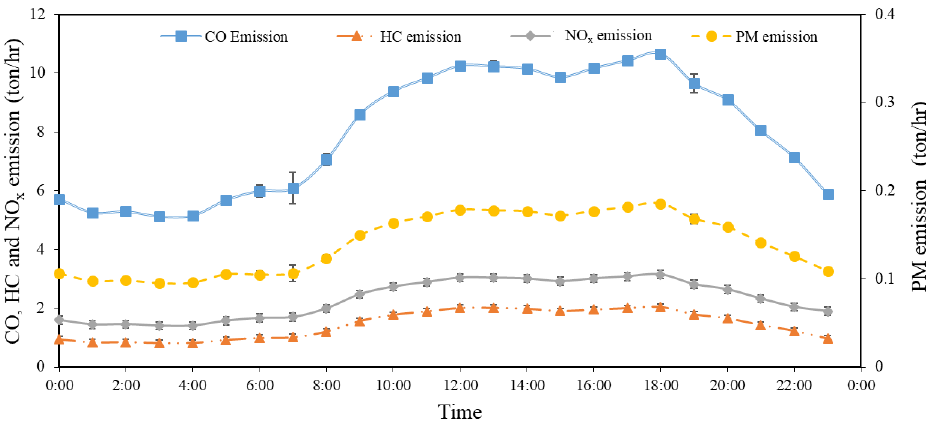
Figure 9. Diurnal distribution of traffic emissions in Bangkok during weekends .